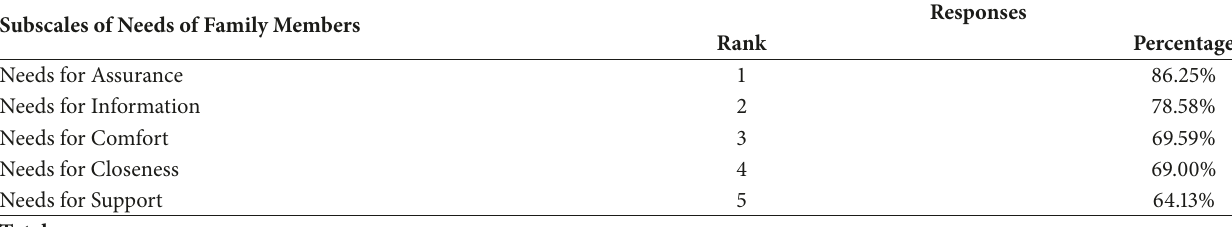
Table 5: Participants’ perception score on five subscales of needs of family